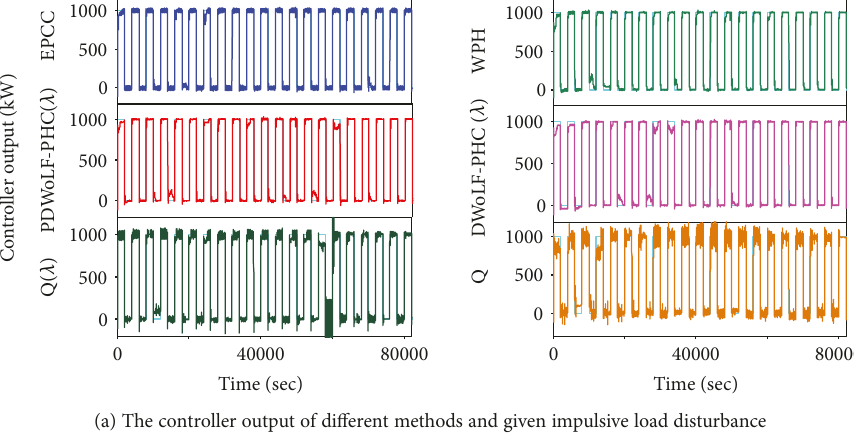
(a) The controller output of di ff erent methods and given impulsive load disturbance